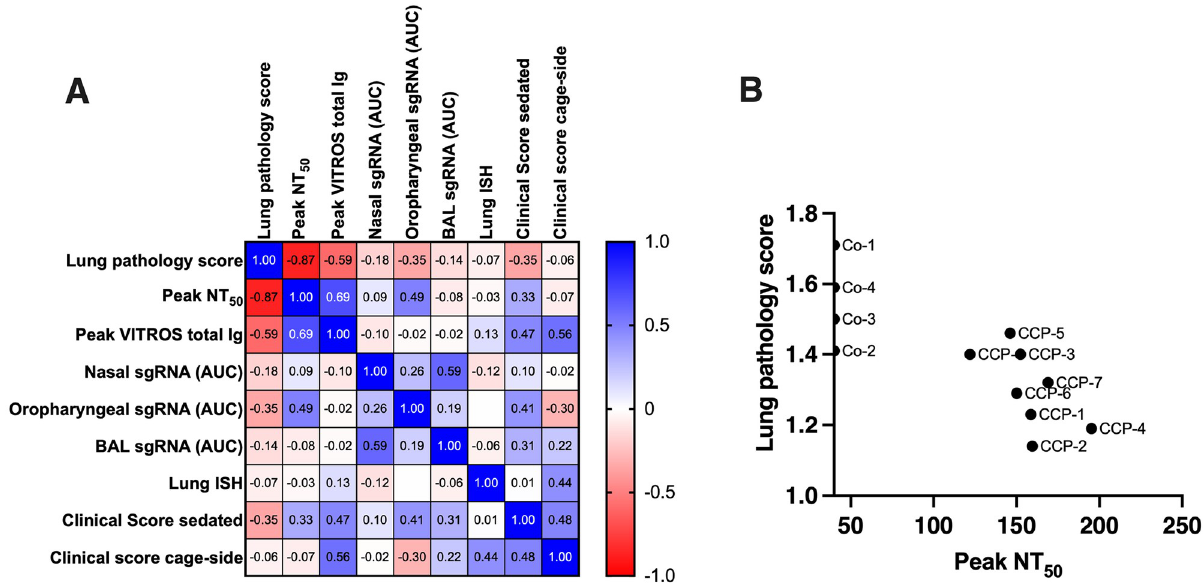
Fig 8. Multivariable correlation analysis. (A). Spearman r correlation matrix in heatmap format. For this analysis, lung pathology scores are the interstitial cellularity scores (from Fig 7). Lung ISH are the in situ hybridization data of Fig 6. Peak NT 50 represents the peak neutralizing antibody titers up to day 5 (i.e., prior to possible de novo antibody responses). VITROS anti-spike total Ig represents the peak value for each animal (i.e., day 2; Fig 2). Nasal, oropharyngeal and BAL sgRNA values are based on AUC of the data in S7 Fig. Clinical scores (sedated and cage-side) are the tabulated scores of each animal over the 7-day observation period (Fig 3C and 3F). (B) Correlation between neutralizing antibody peak NT 50 values and lung pathology scores (Spearman r = -0.87; p < 0.0005). The labels next to each symbol indicate the individual